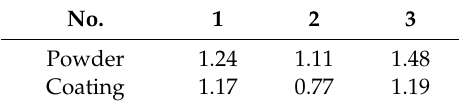
Figure 6. XRD patterns of corresponding LC coatings. Table 4. Average La/Ce atomic ratios of LC feedstocks and corresponding coatings.